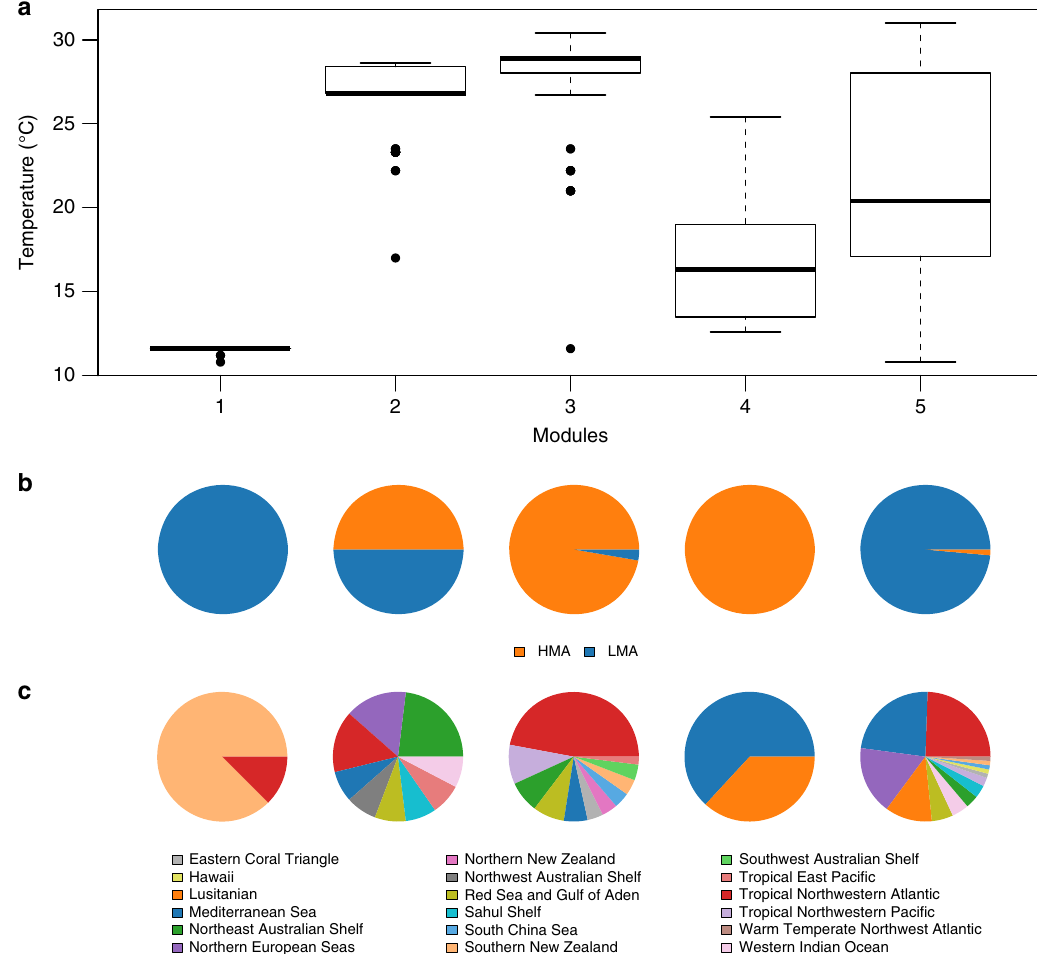
Fig. 1 Drivers of modularity of the global sponge – microbiome network. a Distribution of temperature (in °C) from sponge sampling sites across network modules identi fi ed at the whole network level. Thick line in the middle of boxes represents the median values; box limits are lower and upper quartiles; whiskers, 1.5× interquartile range; points, outliers. b Composition of host type (high- vs. low-microbial abundance sponges, HMA and LMA respectively) per module. c Composition of marine ecoregions from where the samples were collected within each module. Labels for the modules on the x axis in a apply to b and c . Data use to generate this fi gure are available as Supplementary Data LMA sponges (average distance to centroid = 0.47 for HMA vs. 0.64 for LMA).